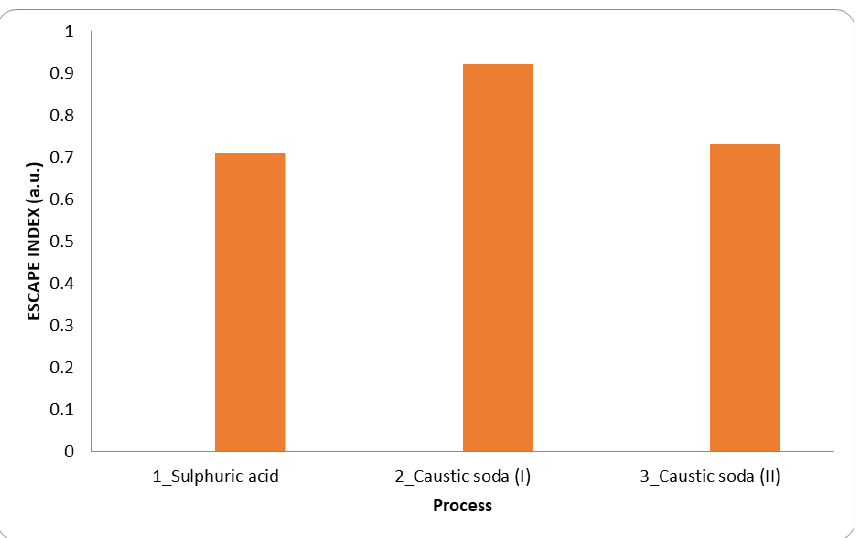
Figure 5. ESCAPE index for the three experimental conditions studied by Ferreira et al., 2008 [21]. It has been considered the case using H 2 SO 4 at L/S = 30 (process n°1) and NaOH (2.5 M) with different L/S: equal to 100 (process n°2), and equal to 30 (process n°3).